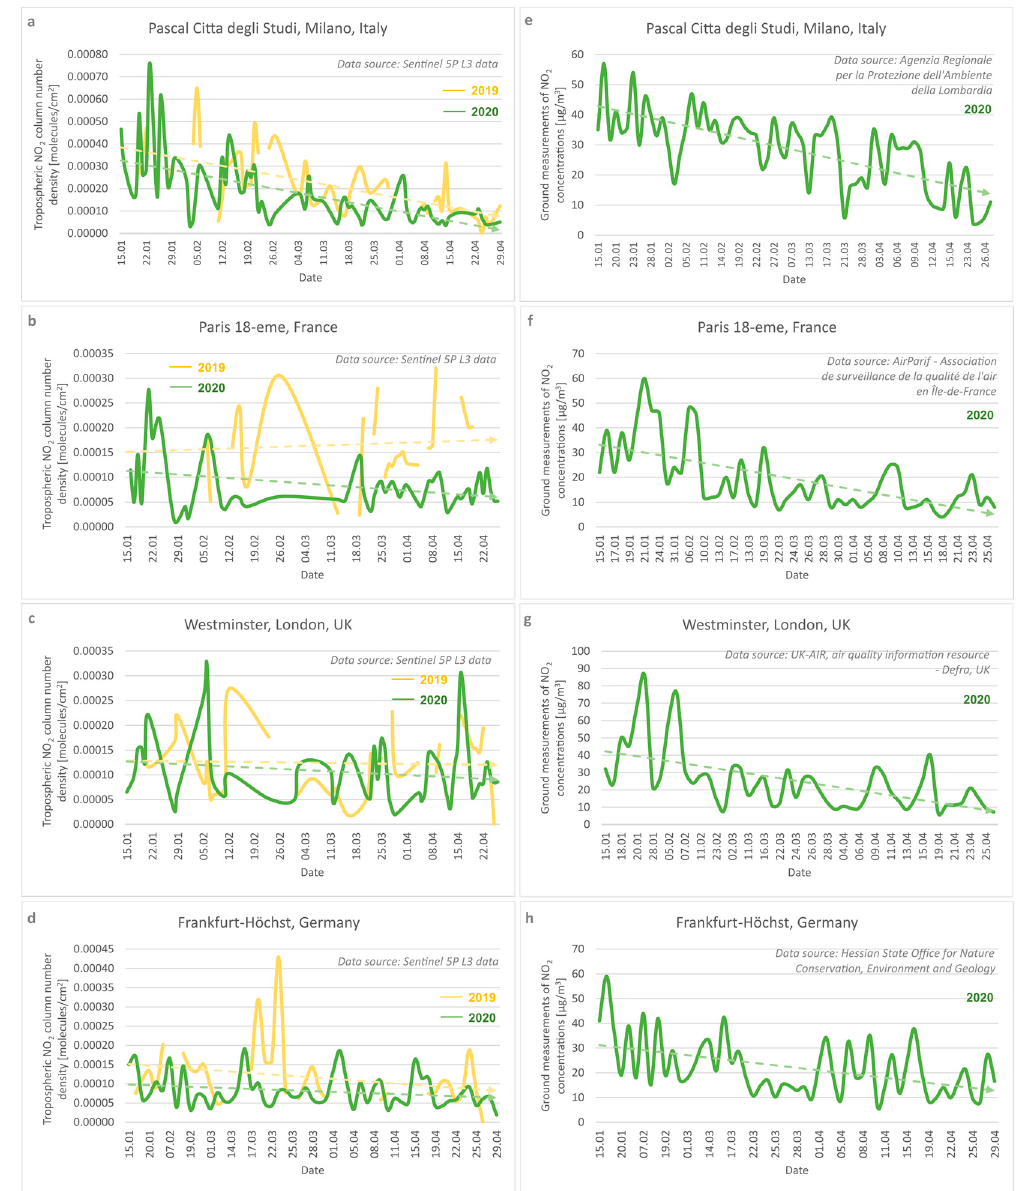
Figure 7. Comparative dynamics of NO 2 daily values for the period between 15 January and 30 April, for different European cities, based on clear-sky TROPOMI data in 2019 and 2020 ( a – d ) and ground-based measurements in 2020 ( e – h ).